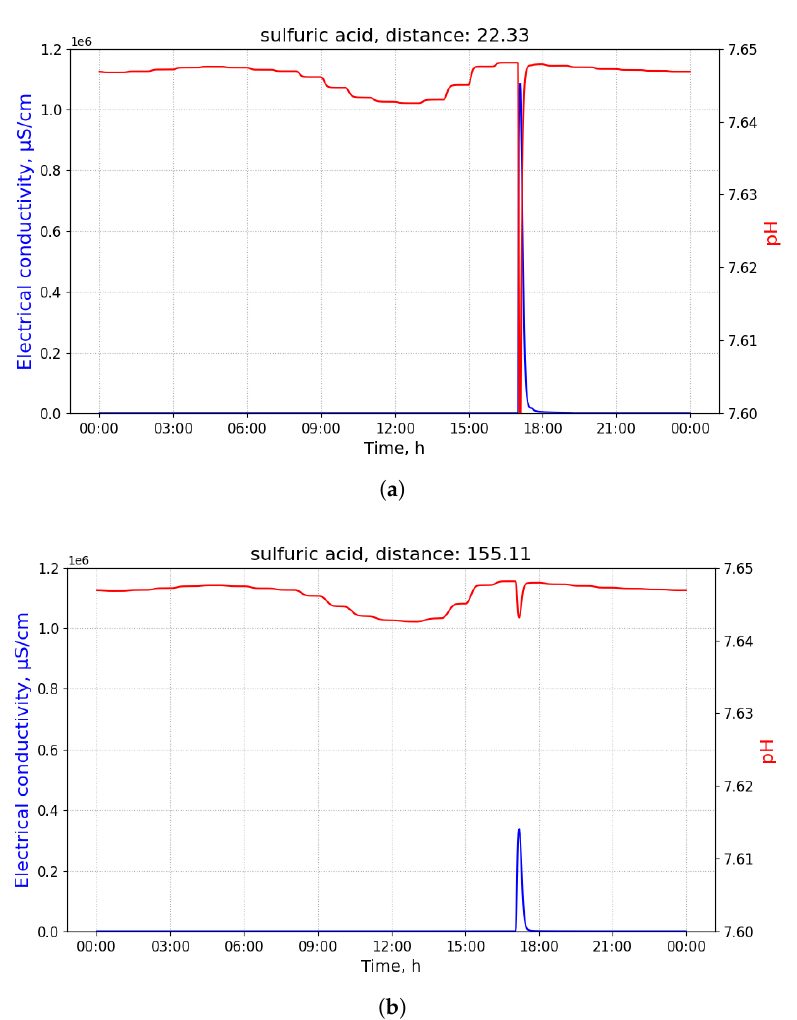
Figure 7. The measurements of pH and electrical conductivity (EC) for the utility network content contaminated with sulfuric acid conducted at different distances. Values of the horizontal axis repre- sent time of the day. ( a ) Measurements of pH and EC for the utility network content contaminated with sulfuric acid conducted at the distance of 22.33 m from the contamination source. Measured at the 02 manhole, discharged at the building B34 with 100 L of the pollutant at 8 a.m. ( b ) Measurements of pH and EC for the utility network content contaminated with sulfuric acid conducted at the distance of 155.11 m from the contamination source. Measured at the 20 manhole, discharged at the building B32 with 100 L of the pollutant at 8